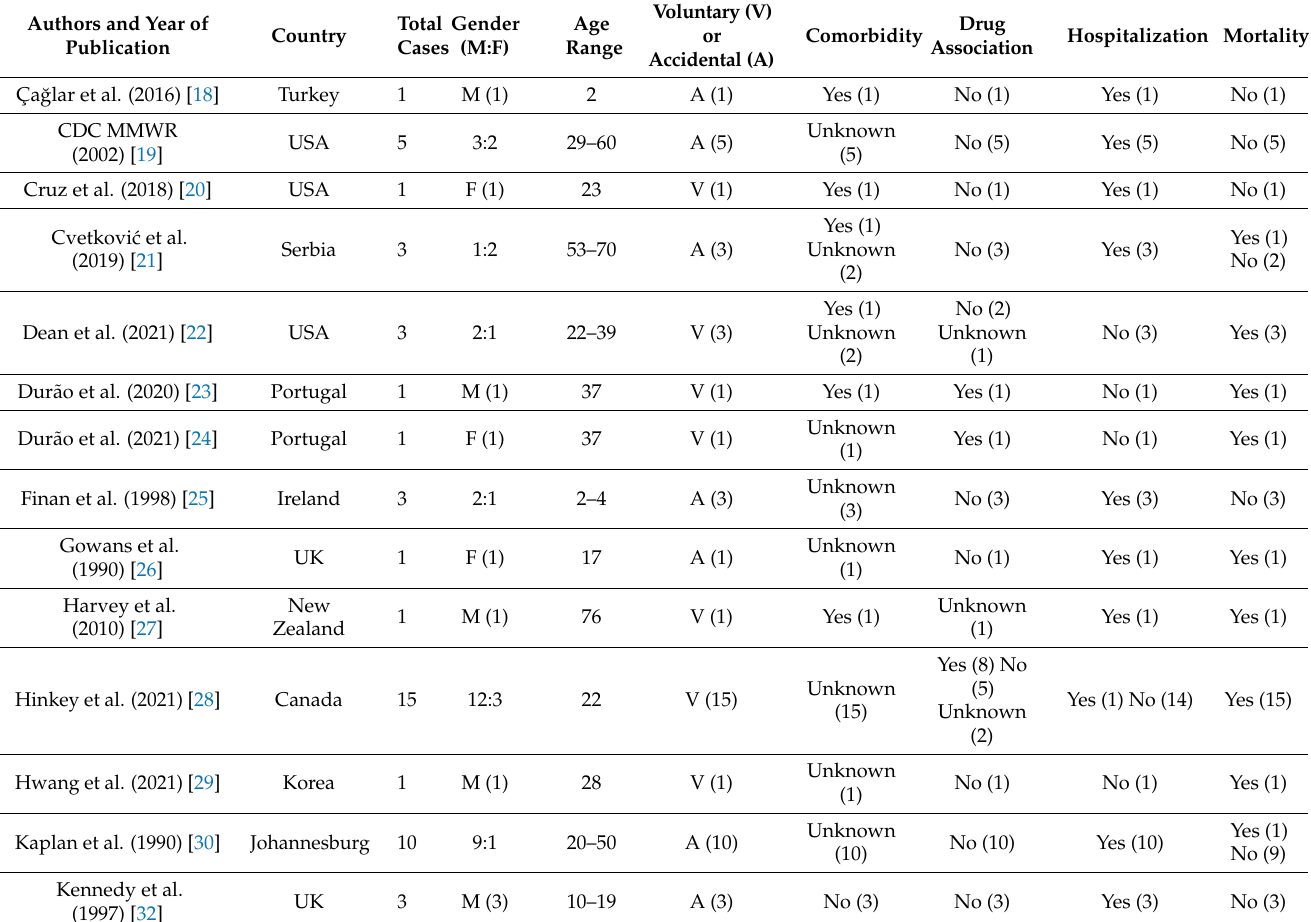
Table 1. Main features of the included